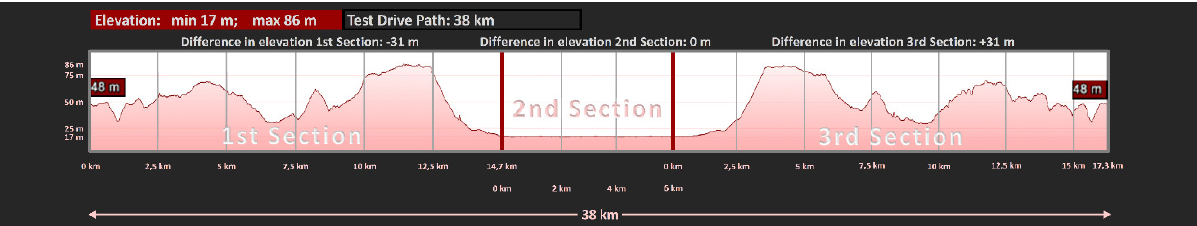
Figure 5. Altimetric profile of the test-path.